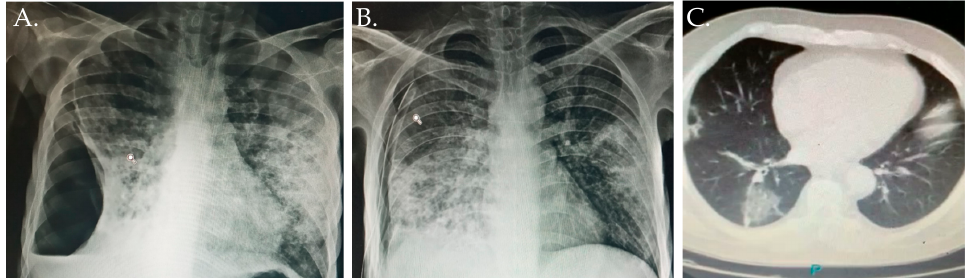
Figure 3. Chest radiography studies. ( A , B ) shows chest radiography study of Case 2. ( A ) Chest radiography of a 31-year-old male showed many small, thick-walled cavities bilaterally; evidence of perilesional ground glass haziness with air space opacities, right pneumothorax about 40%, pleural effusion, and many fibro-parenchymal opacities; a right chest drain tube was inserted ( B ). ( C ) shows a chest CT scan in a 67-year-old male (Case 3) revealing a right cavitary lesion, evidence of perilesional ground glass bilaterally with the largest lesion in the right lower lobe, and consolidative pulmonary opacities.